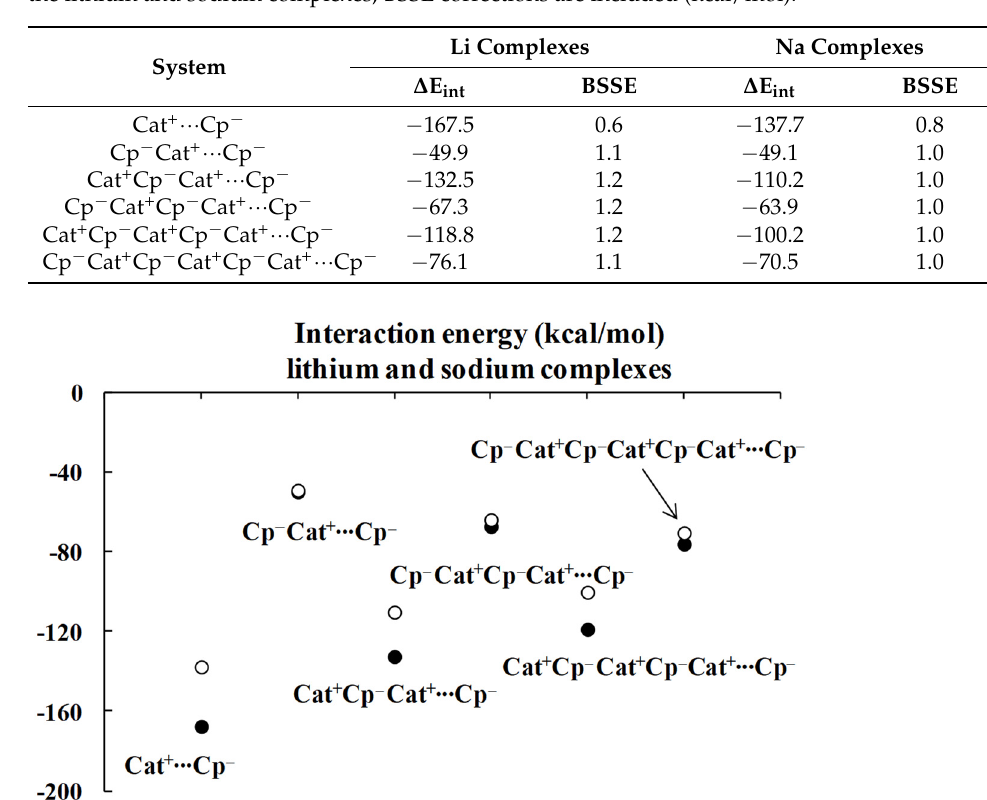
Figure 5. The ω B97XD/6-311++G(d,p) energies of interactions (in kcal/mol) of complexes analyzed here; the lithium species are designated by black circles while the sodium ones are designated by the open circles.